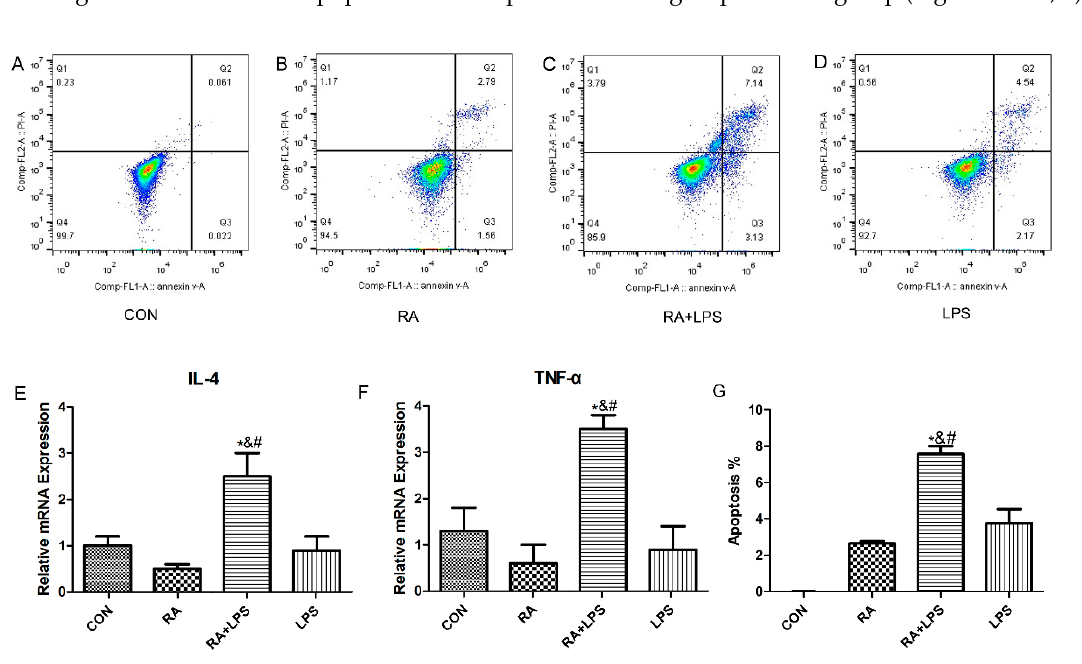
Figure 2. DSG1 deficiency resulted in keratinocytes being vulnerable to injury. ( A – D , G ) Apoptosis rate analysis by flow cytometry. The mRNA levels of IL-4 ( E ) and TNF- α ( F ) were increased when LPS-reated DSG1-deficient Hacat cells. Data are presented as mean ± S.D. * p < 0.05 vs. normal, # p < 0.05 vs. RA, and p < 0.05 vs. LPS.